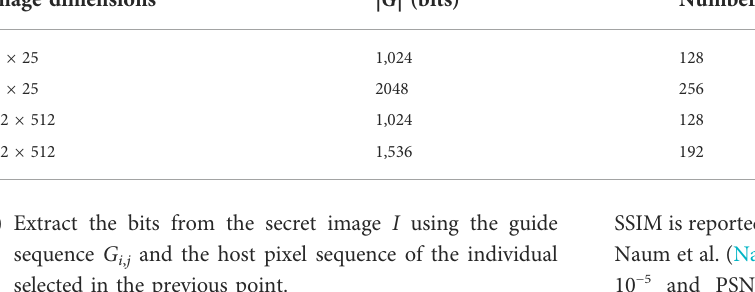
TABLE 3 Algorithmic complexity of the proposed method. Image